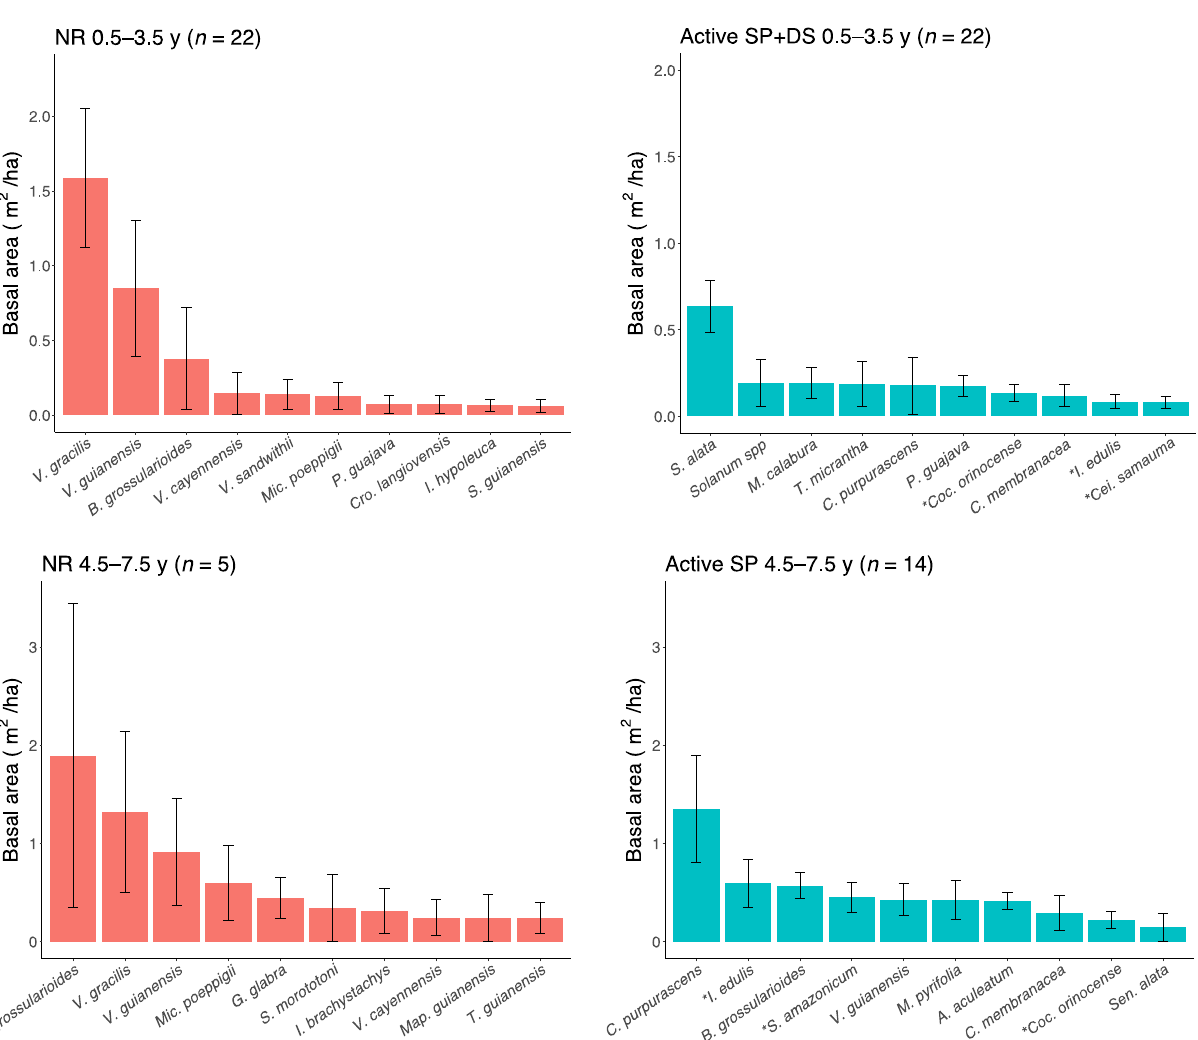
Figure 3. Basal area (mean ± standard error) of the ten most dominant species sampled in sites of natural regeneration (31) and active restoration (36) located in the south of Jirau Hydroelectric Reservoir, along the upper Madeira River. For 0.5–3.5-y-old sites, active restoration included seedling planting and direct seeding of pioneer species (Active SP+DS) and for 4.5–7.5-y-old sites, it included only seedling plantings (Active SP). Species with an asterisk ( * ) were planted as seedlings in active restoration sites.